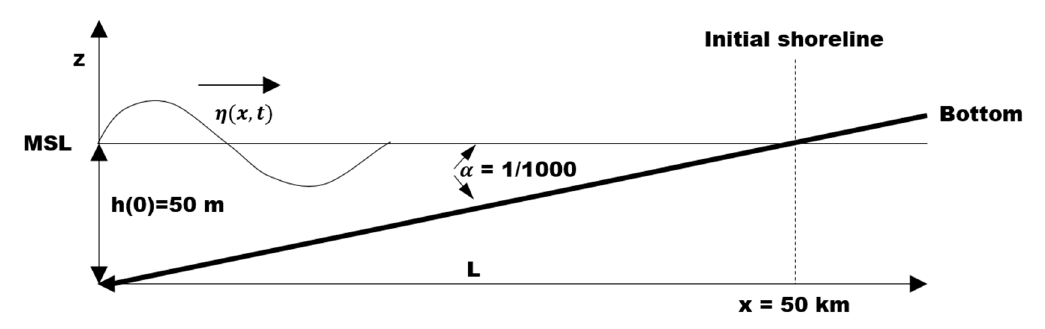
Figure 14. Definition sketch for Carrier and Greenspan [24] analytical solution on a linearly sloping beach, where MSL denotes the mean sea level; h is the water depth; η ( x , t ) is space and time-dependent water surface elevation; and α is the bottom slope.